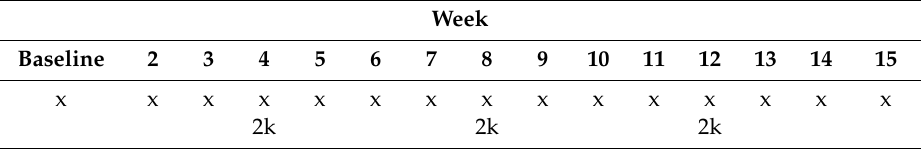
Table 2. Timeline of the HR and HRV monitoring period with 2000 m ergometer